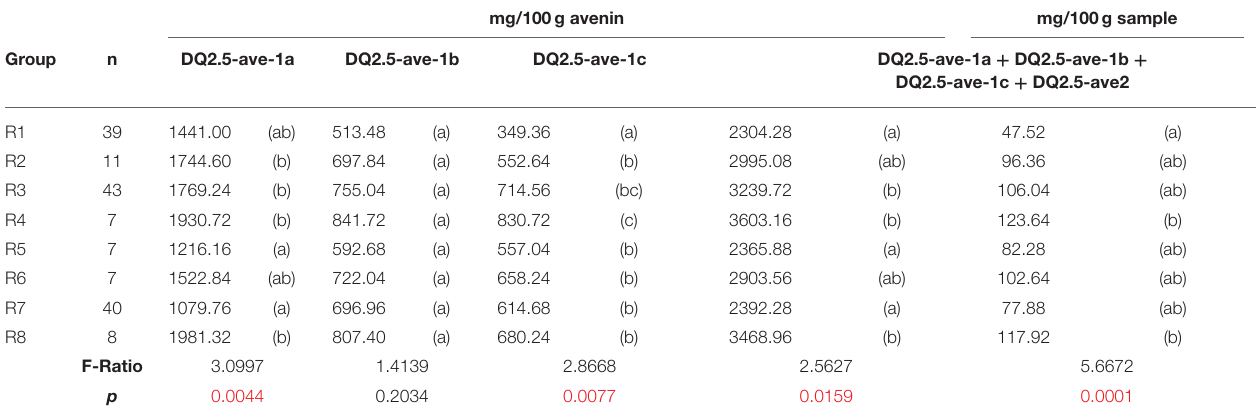
TABLE 4 | ANOVA comparison on the predicted celiac-related avenin epitope contents of samples in the eight regions of origin.